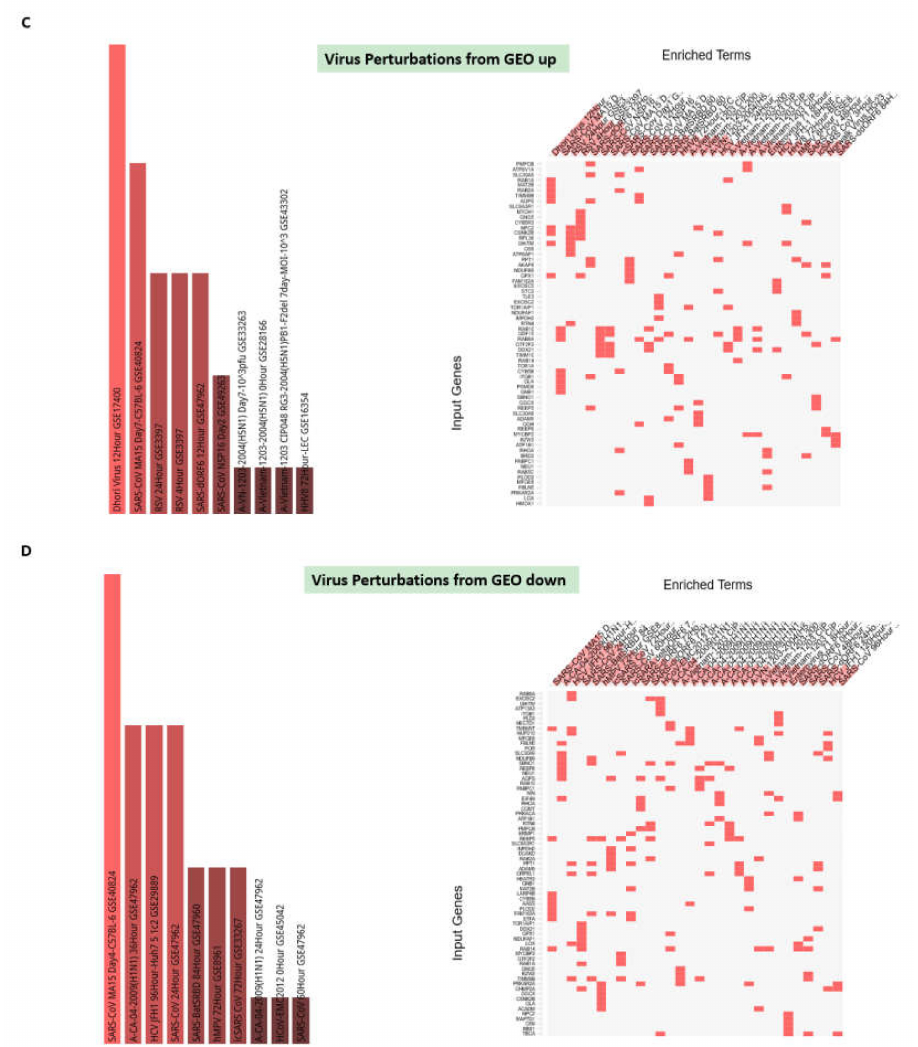
Figure 4. E ff ects of quercetin and vitamin D on expression of genes encoding human prey proteins of SARS-CoV-2. ( A ) Quercetin alters the expression of 98 of 332 (30%) of genes encoding human prey proteins for 23 of 27 (85%) of SARS-CoV-2 proteins. Percent values refer to the fractions of targets a ff ected by quercetin based on gene expression profiling experiments. Both downregulated and upregulated genes were scored assuming that expression changes would alter the stoichiometry of viral protein / human prey protein interactions. Numerical values next to each viral protein names indicate the number of a ff ected target protein-encoding genes. ( B ) Vitamin D alters the expression of 84 of 332 (25%) of genes encoding human prey proteins for 19 of 27 (70%) of SARS-CoV-2 proteins. Percent values refer to the fractions of targets a ff ected by vitamin D based on gene expression profiling experiments. Both downregulated and upregulated genes were scored assuming that expression changes would alter the stoichiometry of viral protein / human prey protein interactions. Numerical values next to each viral protein names indicate the number of a ff ected target protein-encoding genes. Panels C and D report the results of GSEA of the 332 genes in the Virus Perturbations from GEO database for upregulated ( C ) and downregulated ( D ) genes. See text and Supplementary Figure S14 for